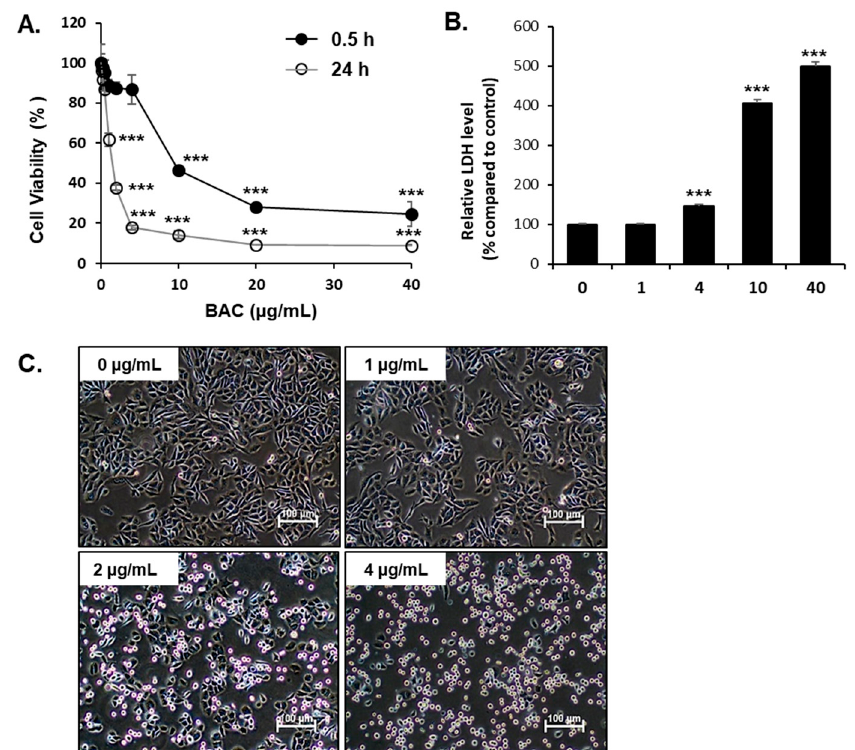
Figure 1. Benzalkonium chloride (BAC) cytotoxicity in human lung epithelial (H358) cells. ( A ) Examination of cell viability using MTT assay in cells after 30 min or 24 h of BAC exposure. ( B ) Determination of lactate dehydrogenase (LDH) leakage from cells after 30 min of BAC exposure. The results are expressed as a percentage compared to untreated cells and each value represents the mean ± SD. ***Significantly different from the corresponding untreated cells (Student’s t-test, p < 0.001). ( C ) Morphological changes in H358 cells treated with BAC for 24 h. Scale bar, 100 μ m.